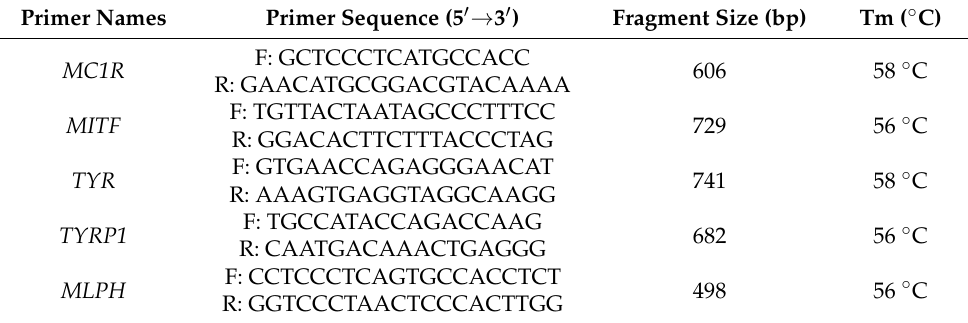
Table 1. Information of primers used for